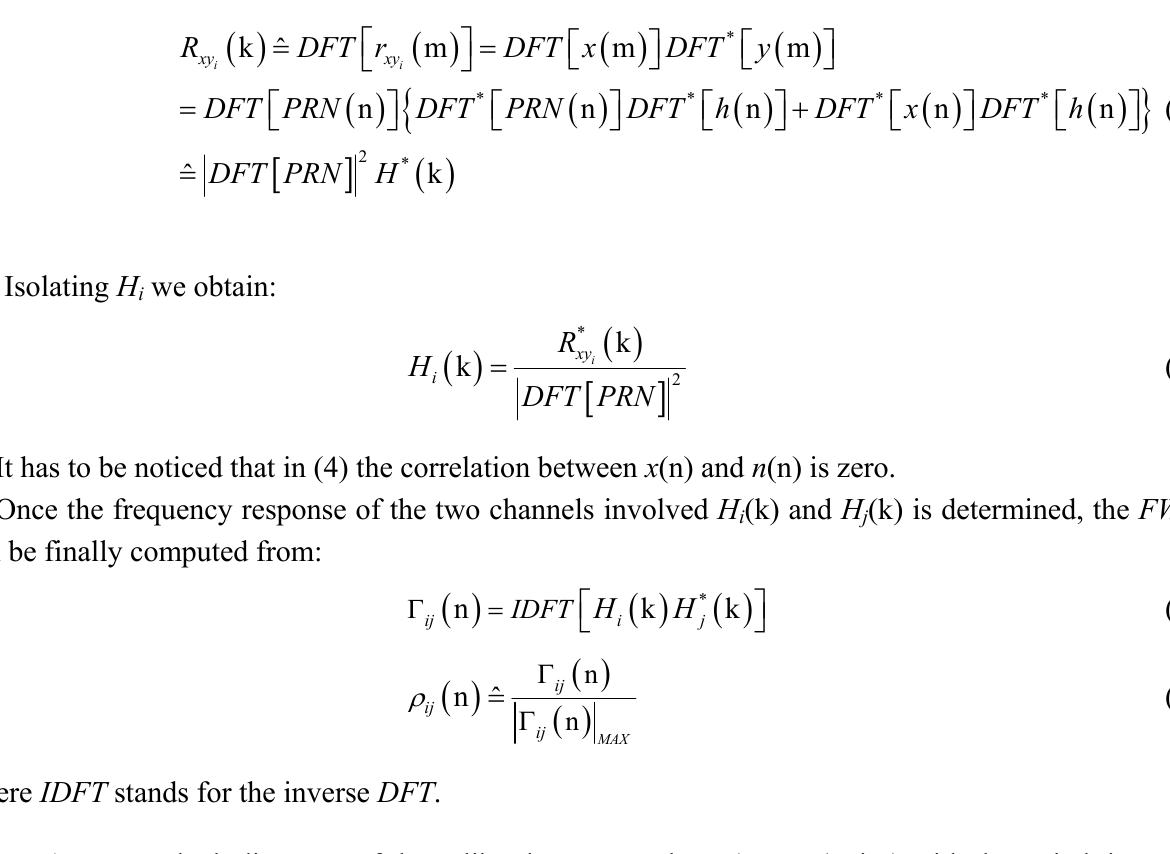
Figure 1. Block diagrams of the calibration approaches. a) FWF (noise) with the switch in position 1 and FWF (Y1·Y2) with the switch in position 2. b) FWF